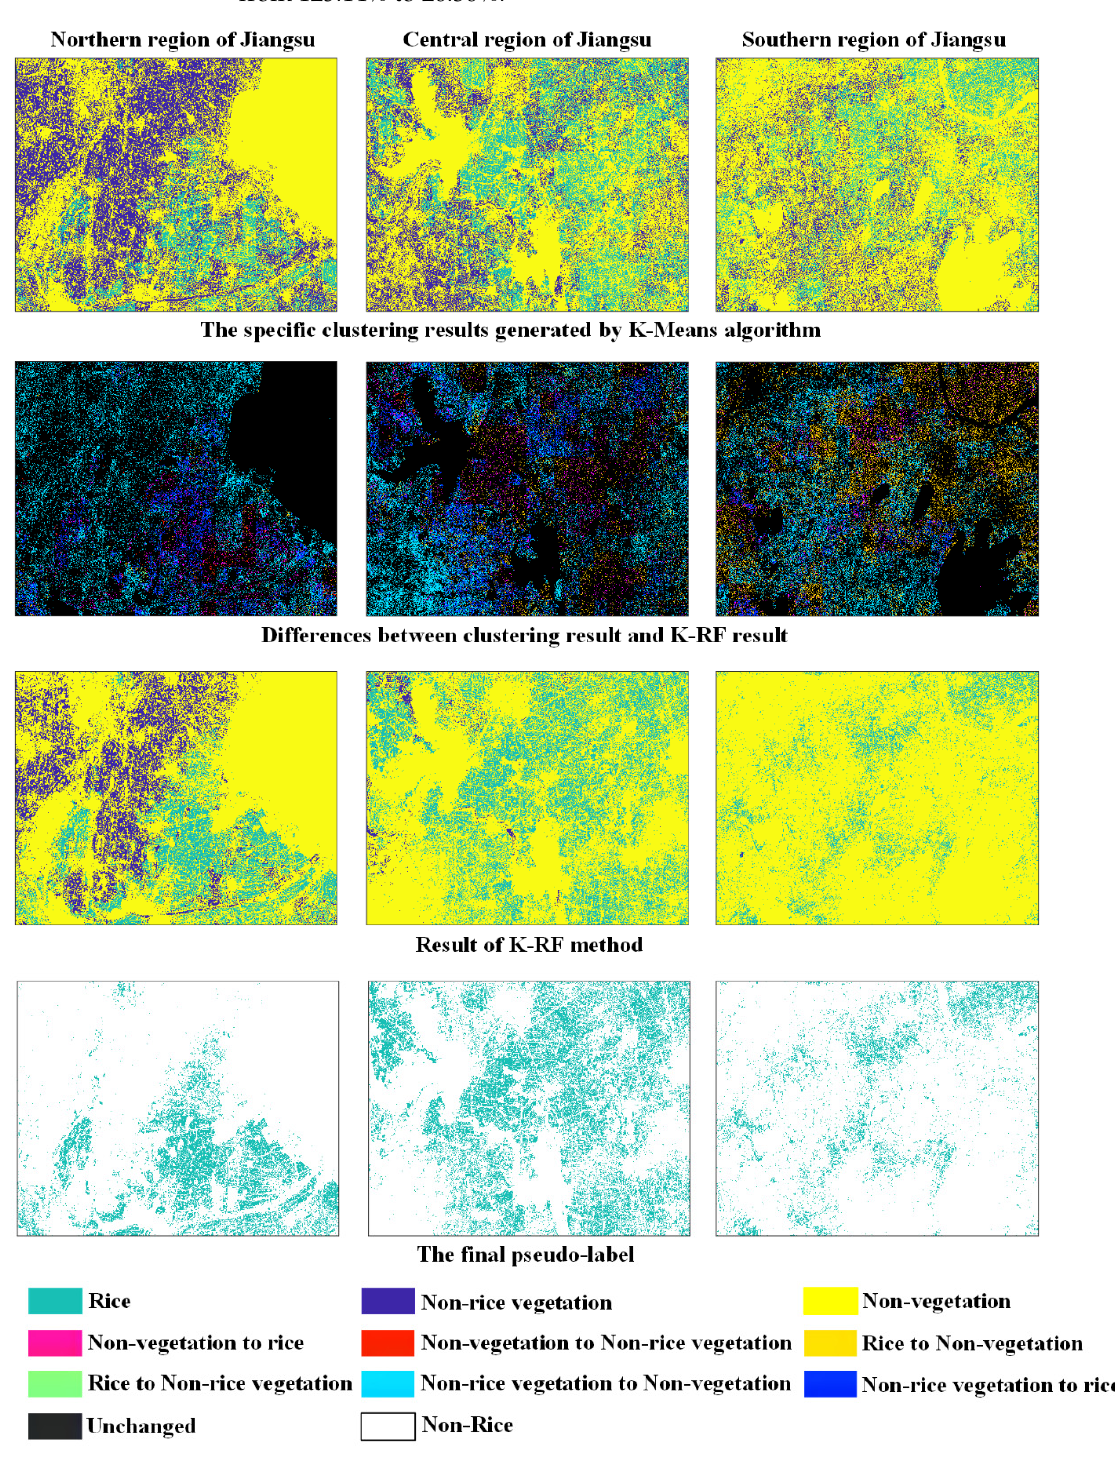
Figure 6. Pseudo-label extraction in the different parts of the target region. The first row is the results of the K-Means algorithm. The third row is the results of the K–RF. The second row is the variations between the points in the same spatial positions as the first and third rows. The fourth row contains the final pseudo-labels generated by the K–RF, which were summarized as rice and non-rice. The first to third columns represent the northern, central and southern target regions, respectively.